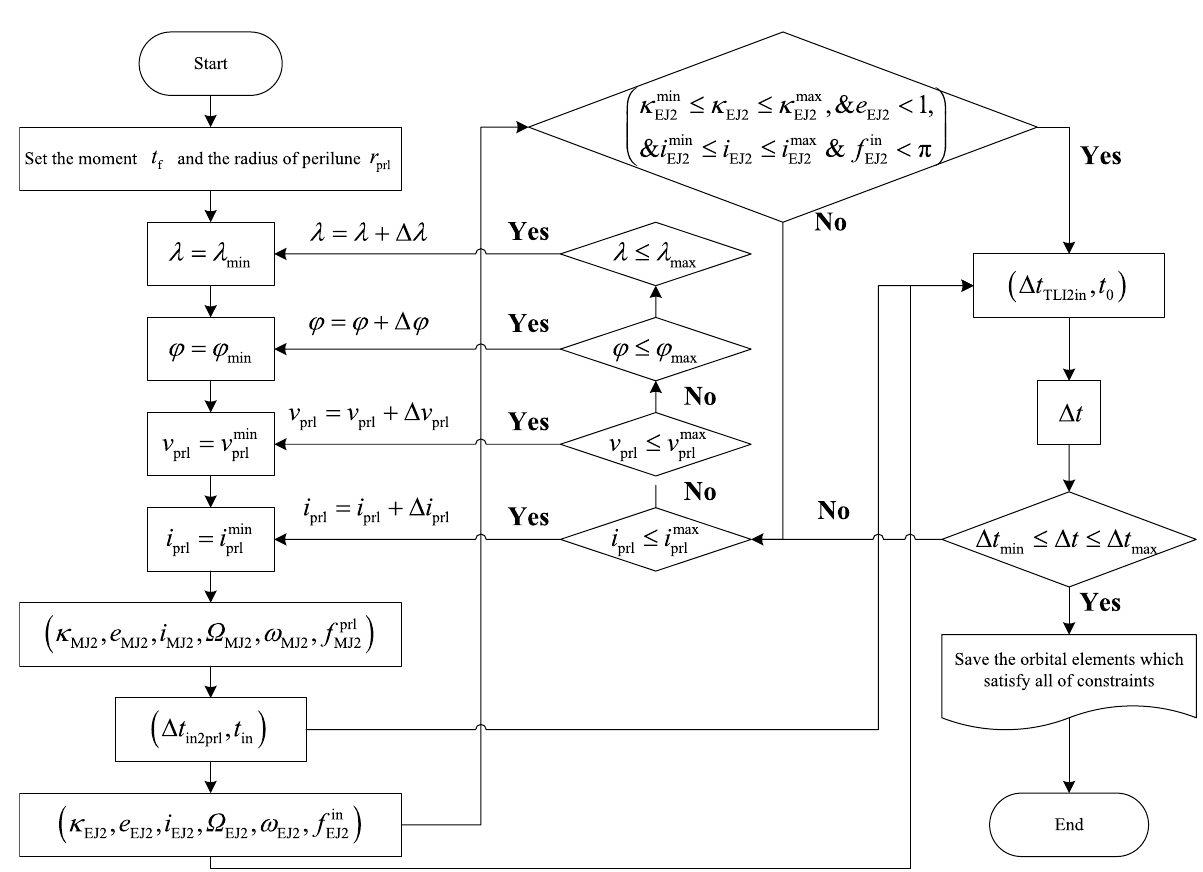
Fig. 5 Flow chart of the multiple‑layer traversal search